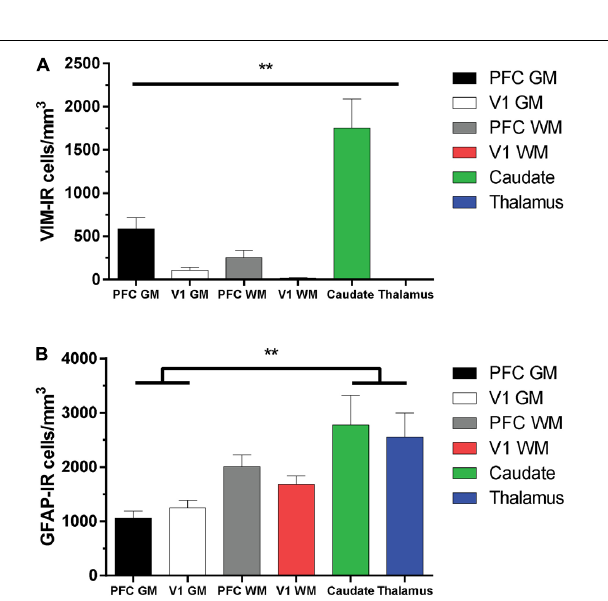
FIGURE 5 | Regional stereological estimates of VIM-IR and GFAP-IR astrocyte density in the adult human brain. (A) There were significantly more VIM-IR astrocytes in the caudate nucleus than in all other brain regions examined, including the thalamus where VIM-IR astrocytes were mostly absent. (B) All human brain regions included in this study were more densely populated by GFAP-IR astrocytes than by VIM-IR astrocytes. There were also significantly more GFAP-IR astrocytes in either subcortical region than in neocortical areas. ** p ≤ 0.01 ( n = 8; Matched One-Way ANOVA).